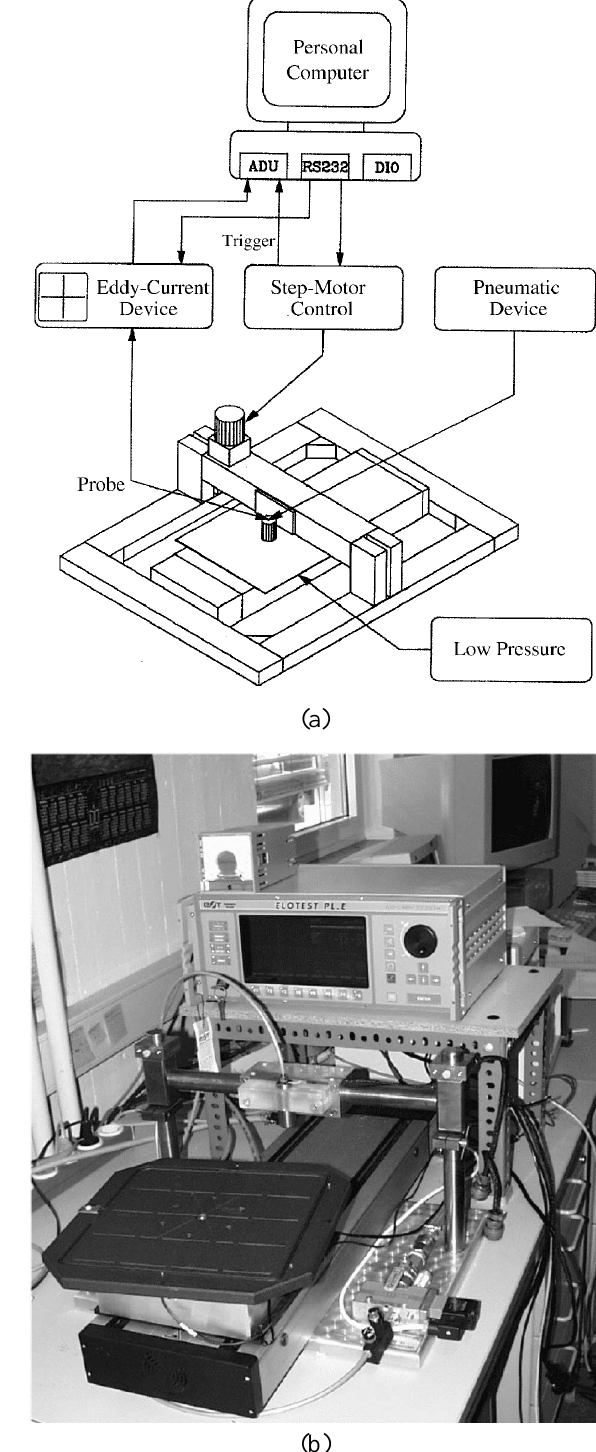
FIG. 19. (a) Schematic view of the xy eddy-current scanning system. (b) Photograph of the new rotating scanning system.